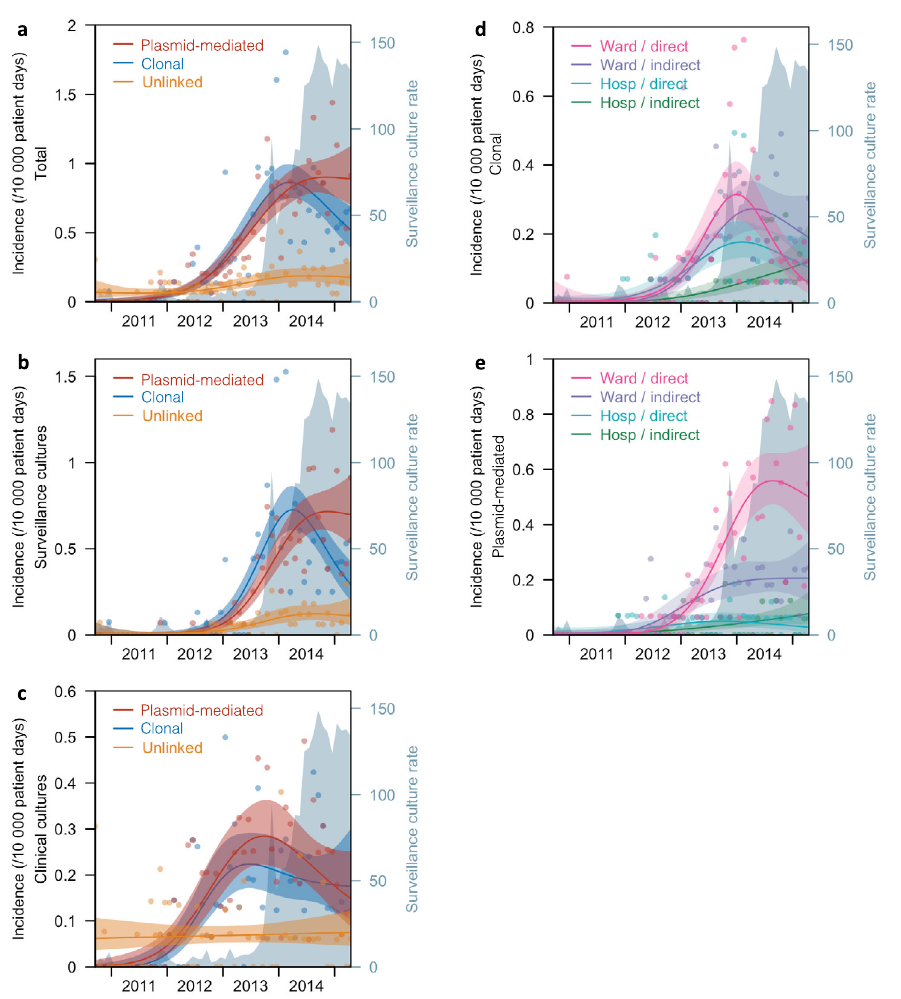
Fig. 2 Incidence of carbapenemase-producing Enterobacterales patients from 2010 to 2015. The data is presented as ( a ) total incidence of patients resulting from putative clonal or plasmid-mediated transmission, or neither, b Incidence of patients among surveillance cultures only, c Incidence of patients among clinical cultures only, d Incidence of patients resulting from putative clonal transmission strati fi ed by hospital or ward contact, e Incidence of patients resulting from putative plasmid-mediated transmission strati fi ed by hospital or ward contact. Incidence is de fi ned as the number of new patient pairs per 10,000 patient-days. Surveillance culture rate is de fi ned as the number of surveillance cultures per 10,000 patient-days. Ward contact was further classi fi ed as direct or indirect, and in the absence of any form of ward contact, direct or indirect hospital contact. Time trends are presented as six- period (month) moving averages. Lines represent the incidence point estimate and the shaded areas represent the 95% CI of the